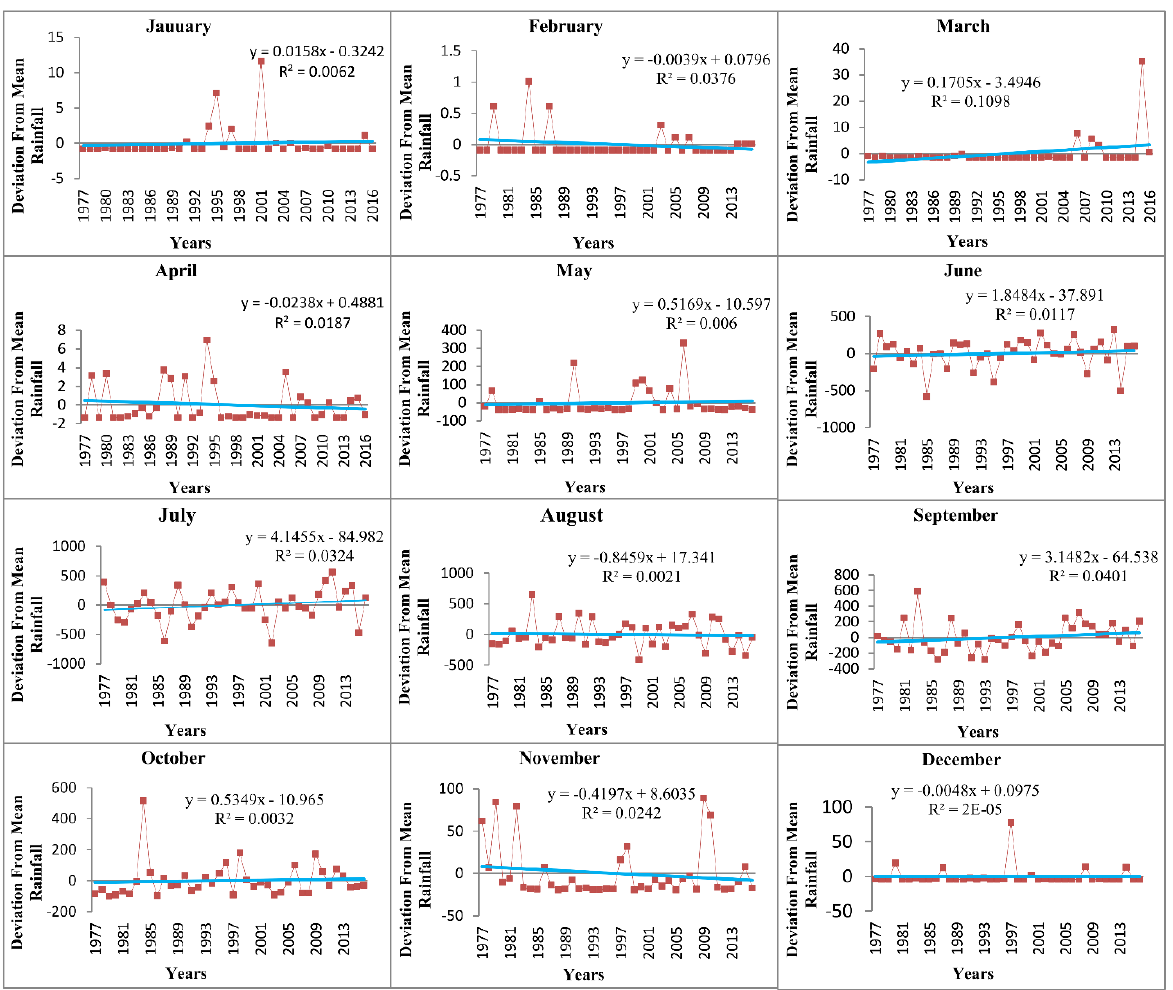
Figure 6. Monthly Rainfall Trends over Konkan &